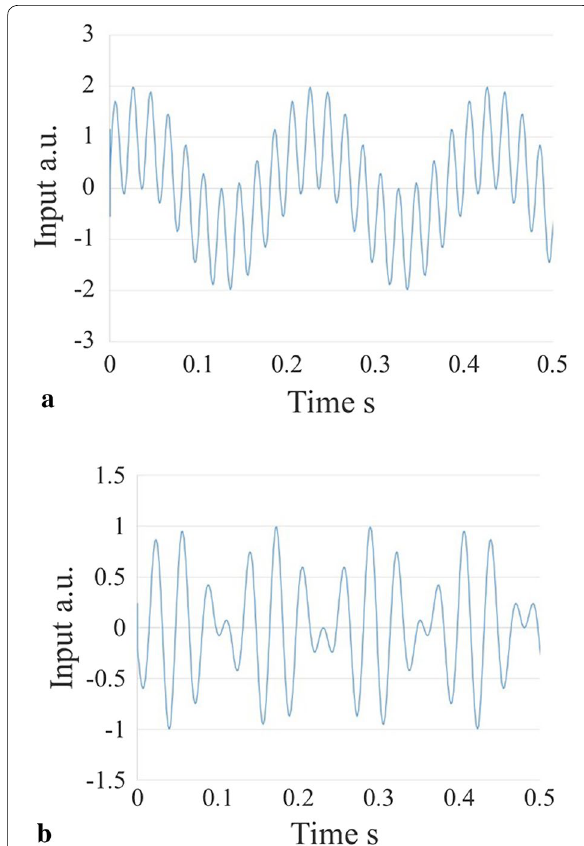
Fig. 3 Examples of two types of noise ( f 1 a Additive noise ( sin 2 πf 1